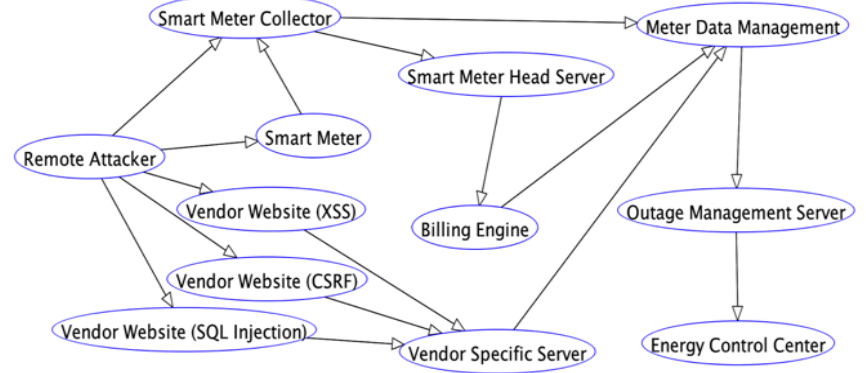
Figure 8. BAGS simulation results: function nodes using the Bayes.jar tool. (XSS refers to Cross Site Scripting; CSRF refers to Cross Site Request Forgery).